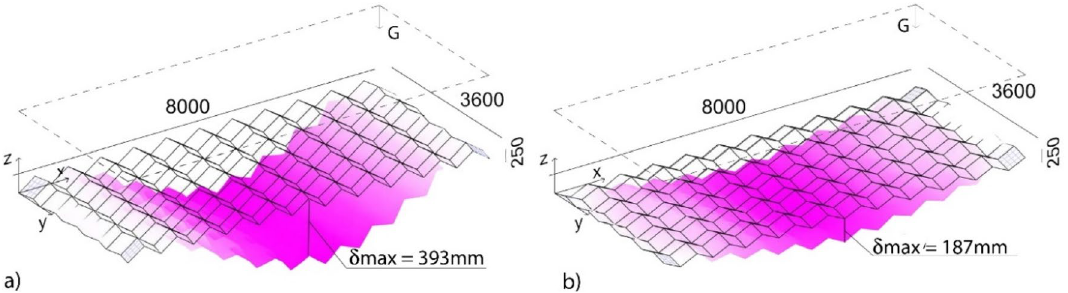
Figure 3. Deflection of ( a ) a Miura Ori tiling (a strict origami) and ( b ) an egg-box tiling (an origami-like structure) under